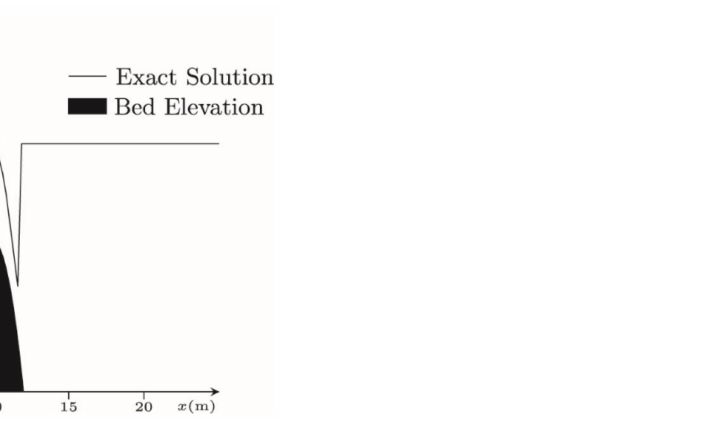
Figure 8. Analytical steady-state free surface elevation distribution [24] along a channel for the case of transcritical flow over a bed hump.